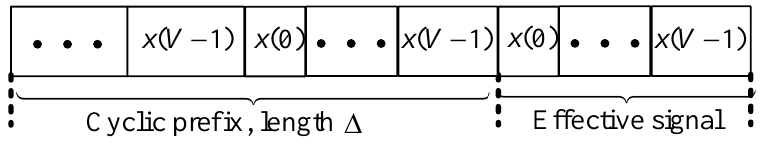
Figure 1. Symbol structure of OFDM